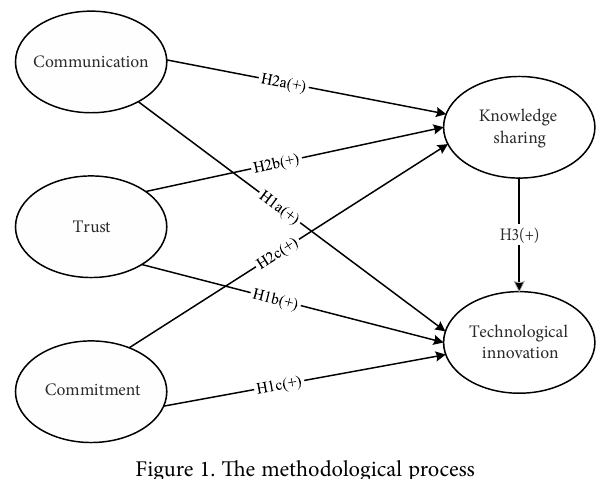
Figure 1. The methodological